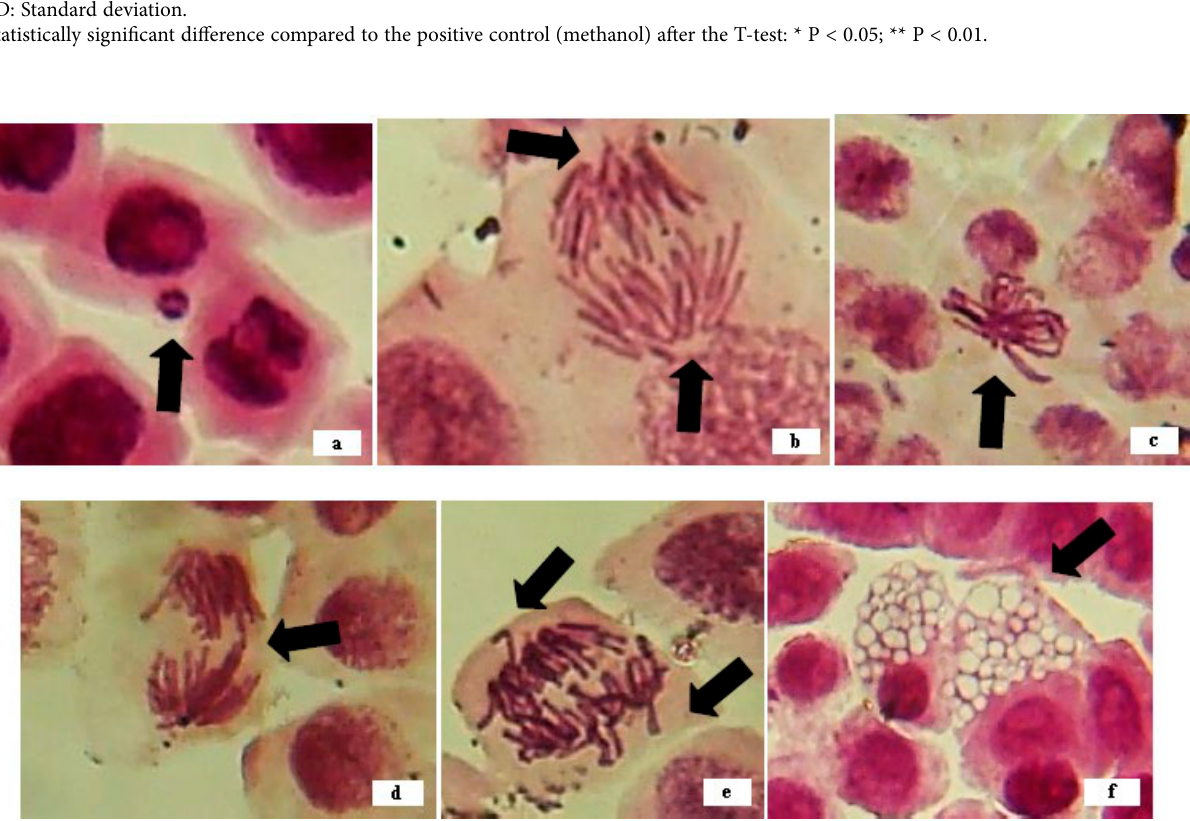
Fig. 1 Genotoxic effects of Allium cepa meristem cells treated with P. major extracts from Tetovo: a- micronucleus, b- multipolar anaphase, c- sticky chromosomes, d- anaphase bridge, e- vagrant chromosomes, f- necrotic